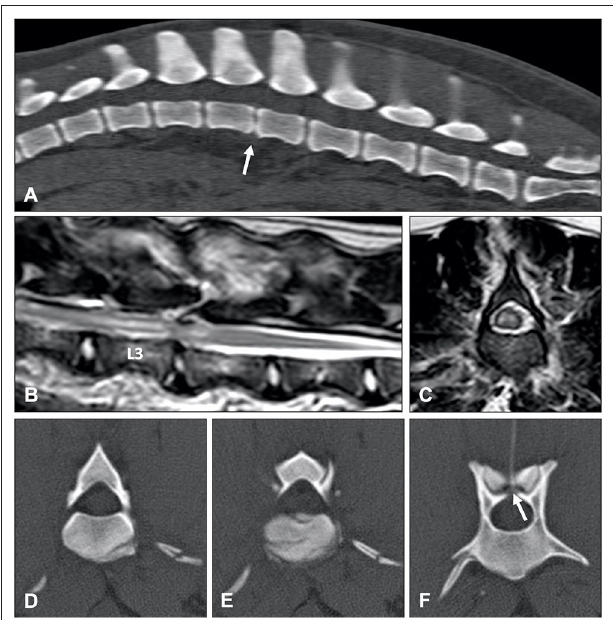
FIGURE 11 | ANNPE can occur after external trauma. CT can be used to exclude or characterize concurrent vertebral fractures and luxations. (A) Sagittal reconstructed CT study of a 6-year old Boxer who became paraplegic immediately after a road traffic accident. Although a narrowed intervertebral disc space (arrow) is in itself not sufficient to confirm a diagnosis of ANNPE, the CT study was able to exclude the presence of a vertebral fracture and luxation. Sagittal (B) and transverse (C) T2-weighted MR images and transverse CT images at the levels of caudal L3 (D) , the caudal vertebral endplate of L3 (E) and cranial L4 (F) of a 4-year old Border collie who ran into a tree. Although the MRI (A,B) reveals abnormalities suggestive for ANNPE, there are also abnormalities suggestive for external trauma, such as diffuse and bilateral hyperintensities in the paravertebral muscles. (C–E) The CT study revealed multiple fractures and (D) a mildly increased distance between the cranial and caudal articular processes.